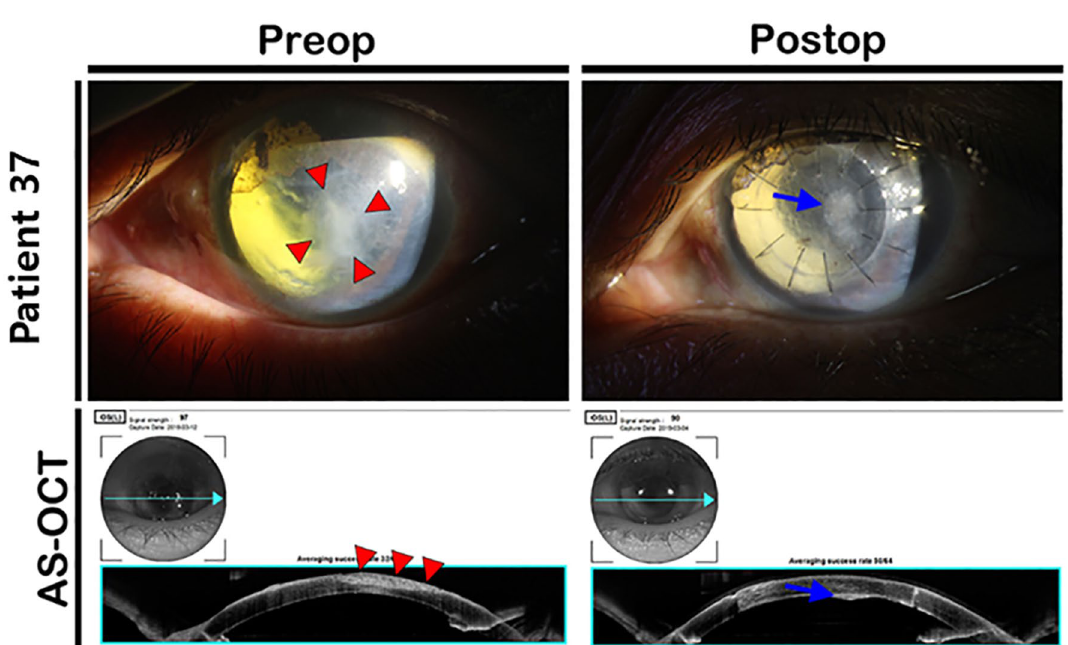
Figure 6. Representative cases of corneoscleral graft. Patient 25 presented with a relatively large diameter corneoscleral penetration site at the 3 o’clock position (red arrow). A corneoscleral graft using a remnant rim of corneal donor remnant tissue was well fitted to the penetration site (asterisk, top row). Postoperative slit-lamp examination and AS-OCT revealed good cosmesis with well-formed corneoscleral integrity (blue arrowheads). Patient 26 presented with widespread corneoscleral melting related to necrotizing sclerokeratitis (red arrowheads). Partial thickness corneoscleral graft and conjunctival rotation autograft were performed (asterisk). The grafts aligned to the corneal and scleral borders of the limbus, and had good cosmetic and anatomical outcomes (blue arrowheads). Preop—preoperative; Postop—postoperative; AS-OCTpost—postoperative anterior segment optical coherence tomography; AS-OCT—anterior segment optical coherence tomography.